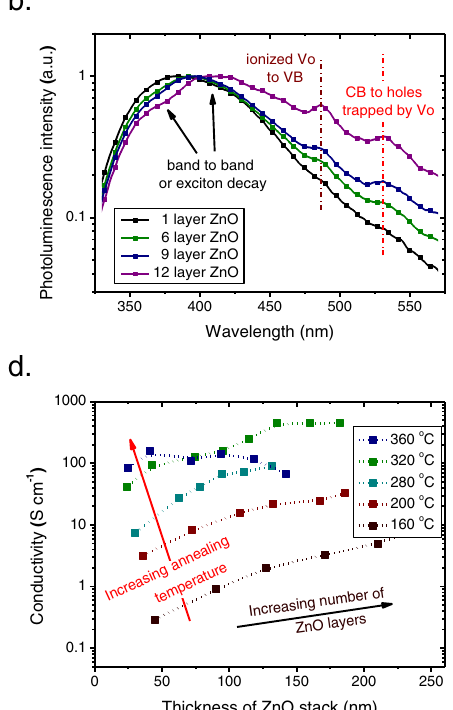
Fig. 4 | ZnO grown using the sequential deposition strategy. a Schematic representation of the sequential deposition strategy for the growth of the ZnO stack. The use of polydimethylsiloxane (PDMS) is for the patterning of the ZnO stack, later to be used for constructing optoelectronic devices. b PL spectra of the ZnO stacks with different numbers of ZnO layers, annealed at 320 o C (excitation